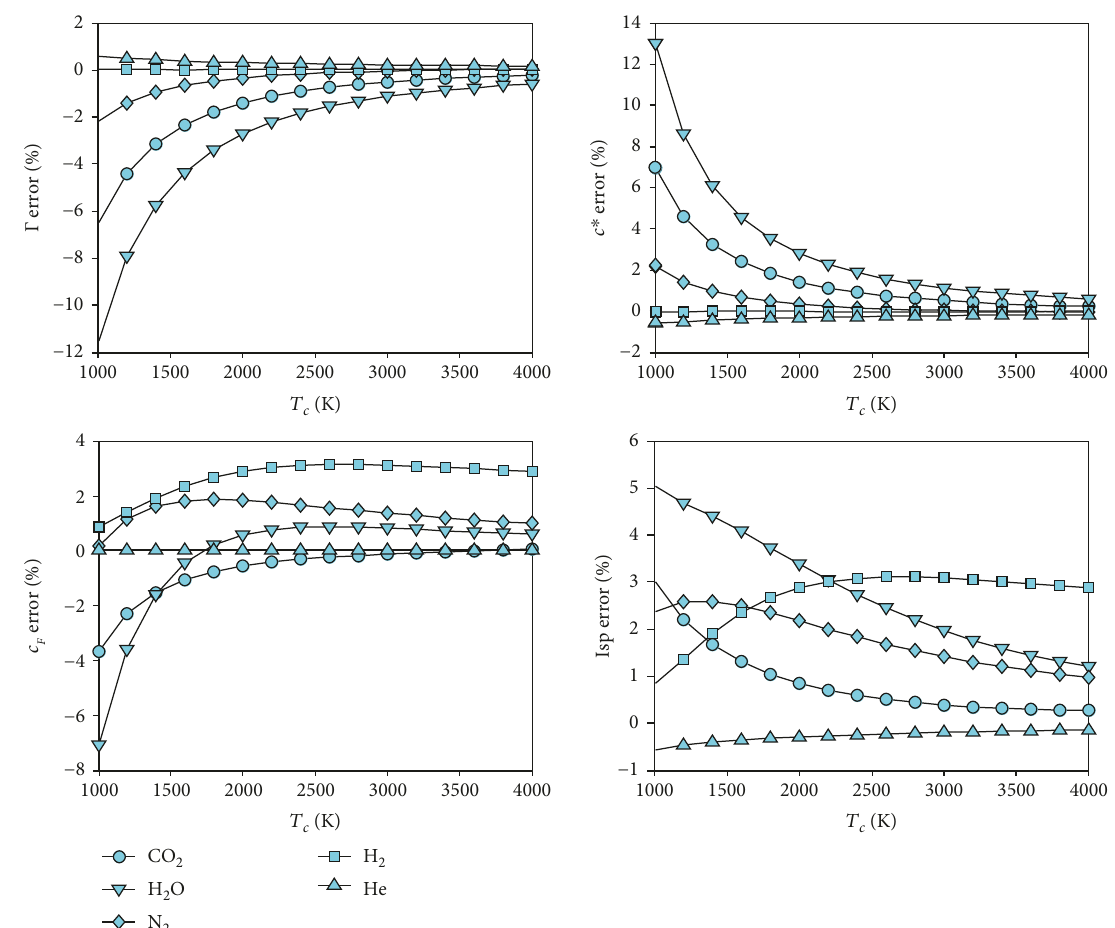
Figure 1: Errors of propulsion parameters of calorically perfect ideal gases with respect to VDW gases at di ff erent chamber temperatures, for / A = 100 and P = 10 vacuum expansion, A e t c